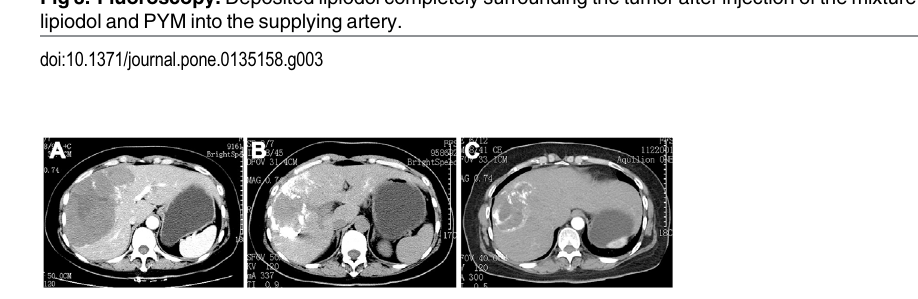
Fig 4. Female patient before and after TAE. (A): before TAE the hepatic hemangioma filled almost all of the right liver. Three months after TAE, the hepatic hemangioma was smaller than before TAE (B), and it became even smaller six months later (C).